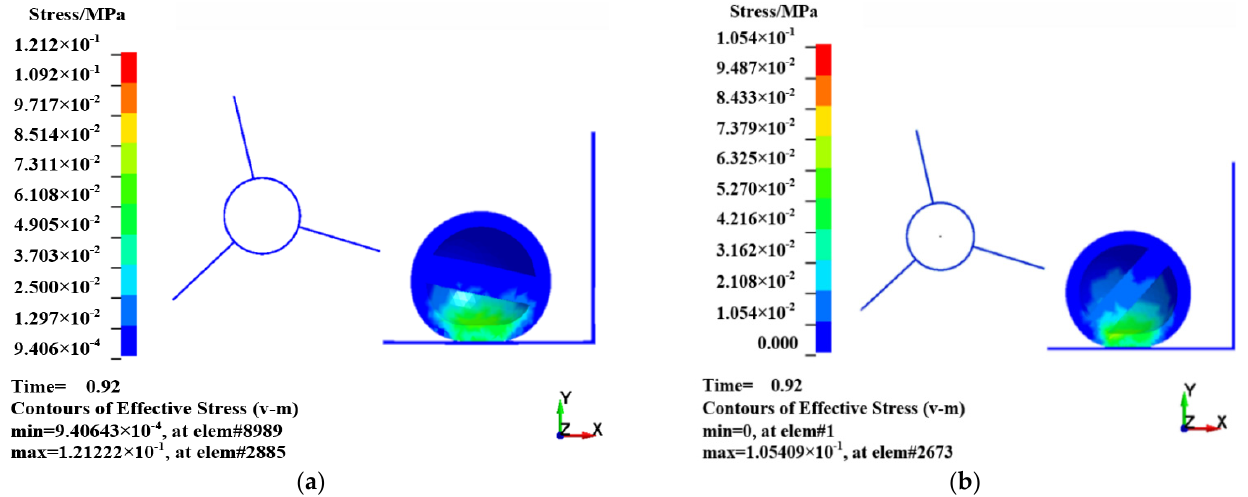
Figure 11. Simulation results of tomato drop in condition 3 with ( a ) PVC material and ( b ) Corrugated paper material.